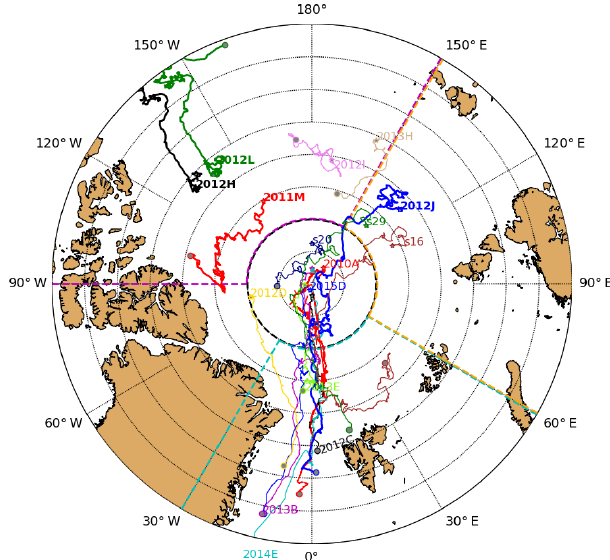
Figure 1. Drift trajectories of all selected buoys (IMBs and snow buoys) in 2010 to 2015. The symbol “ (cid:63) ” indicates the start of the drift and “ ◦ ” signals the end of the drift. Buoys are labelled at the beginning or the end of the drift using the same colour as trajecto- ries. Buoys used for model simulations are highlighted with a solid thick line and bold font. Dashed thick lines illustrate our defini- tion for sectors: central Arctic (black; north of 86 ◦ N), and south of 86 ◦ N: Pacific sector (magenta; 90 ◦ W–150 ◦ E), Atlantic sector (cyan; 30 ◦ W–60 ◦ E) and Laptev Sea (orange; 60–150 ◦ E) used in Fig.